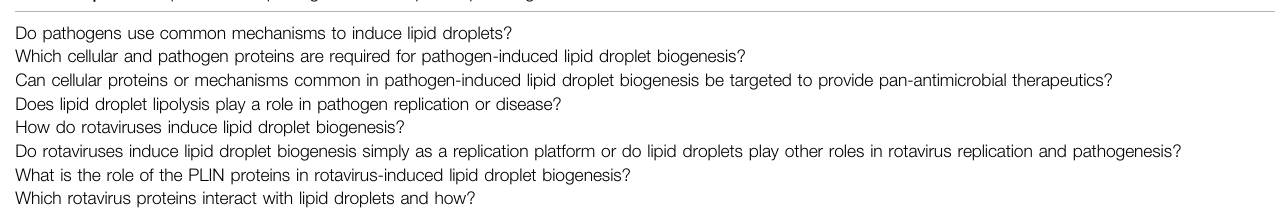
TABLE 1 | Current questions for pathogen-induced lipid droplet biogenesis research. Do pathogens use common mechanisms to induce lipid droplets? Which cellular and pathogen proteins are required for pathogen-induced lipid droplet biogenesis? Can cellular proteins or mechanisms common in pathogen-induced lipid droplet biogenesis be targeted to provide pan-antimicrobial therapeutics? Does lipid droplet lipolysis play a role in pathogen replication or disease? How do rotaviruses induce lipid droplet biogenesis? Do rotaviruses induce lipid droplet biogenesis simply as a replication platform or do lipid droplets play other roles in rotavirus replication and pathogenesis? What is the role of the PLIN proteins in rotavirus-induced lipid droplet biogenesis? Which rotavirus proteins interact with lipid droplets and how?